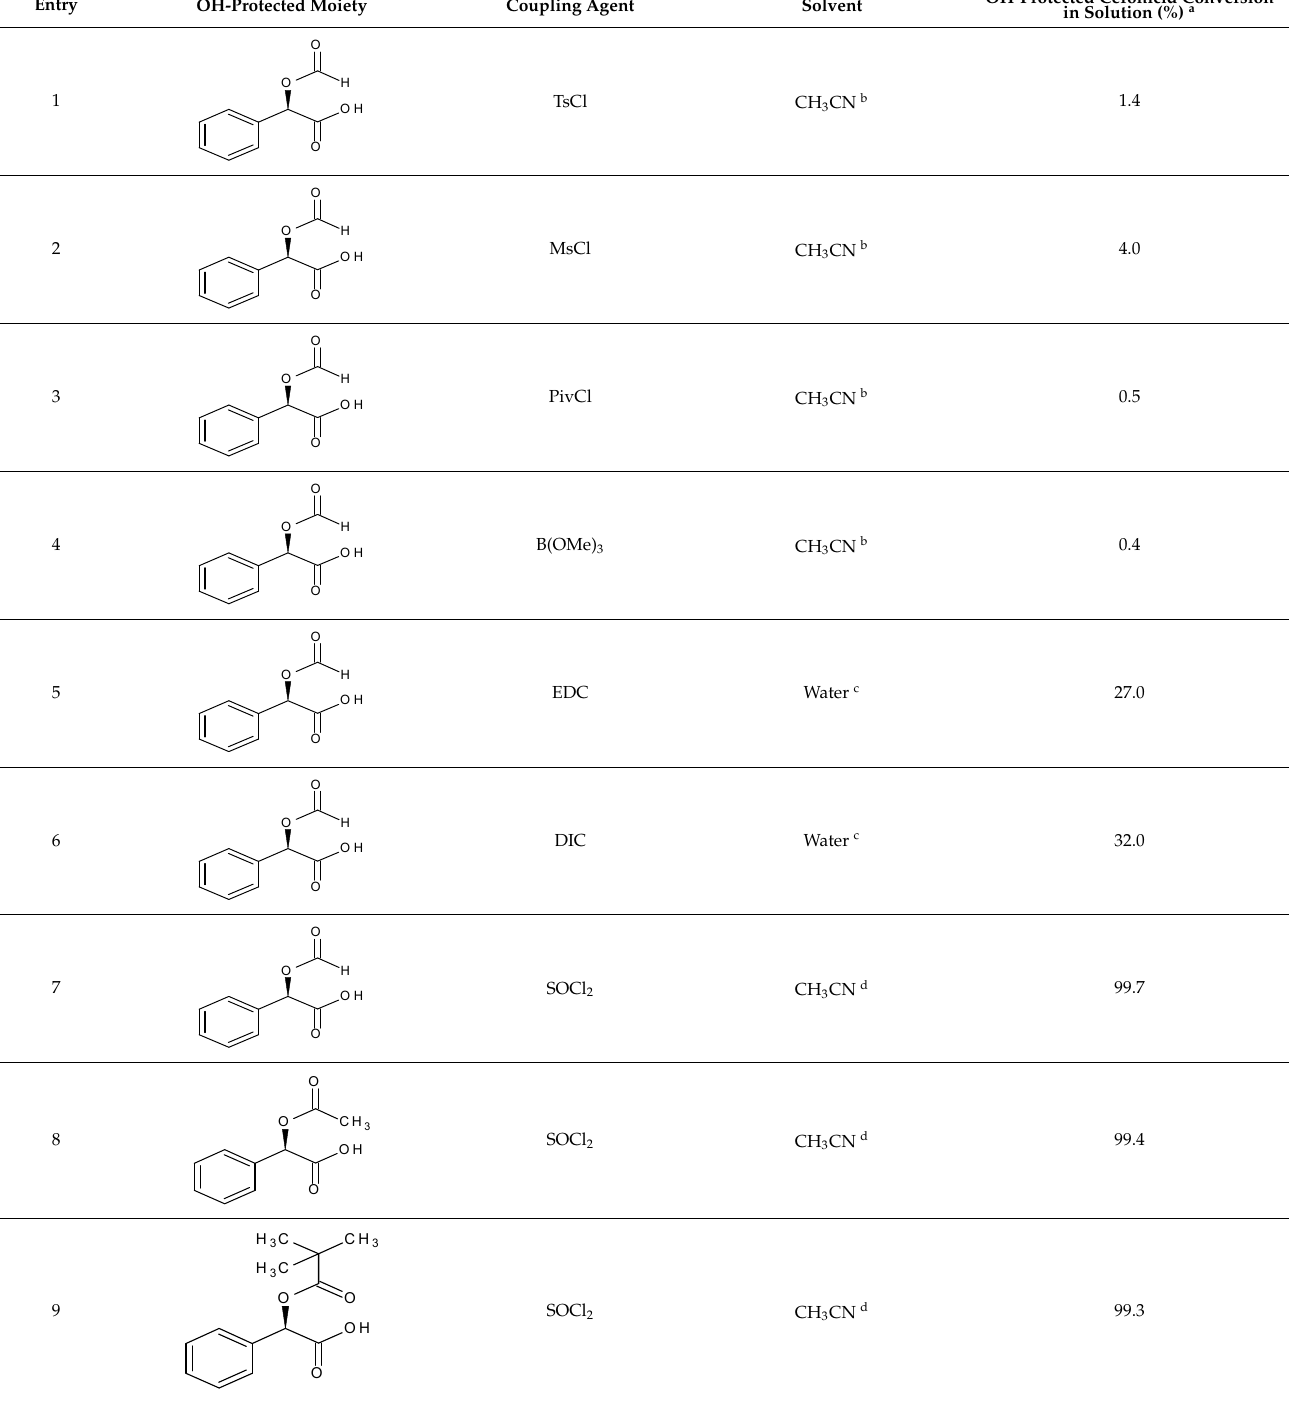
Table 2. Amidation with OH-protected mandelic acid.